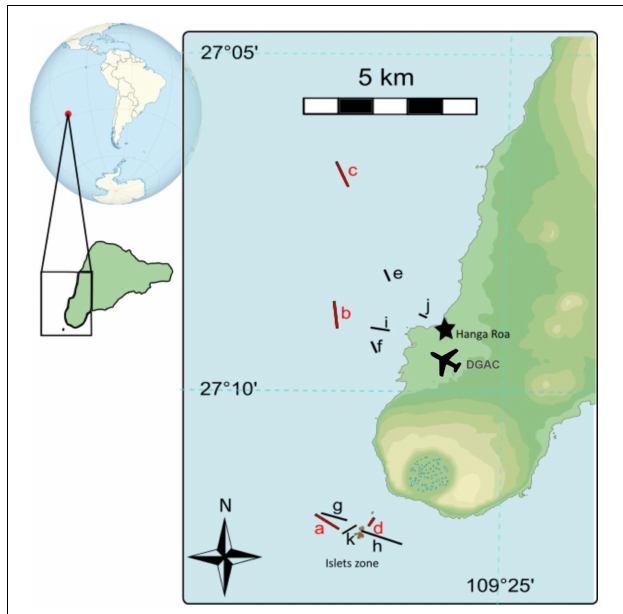
FIGURE 1 | Map and position of transects in the slicks from Rapa Nui. All slicks identified with a letter in the order they were sampled in (red letter) 2018, and (black letter) 2019.